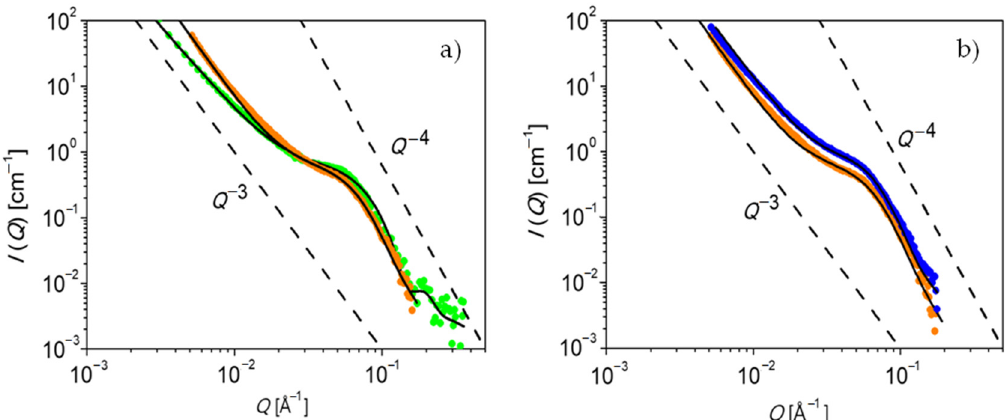
Figure 6. ( a ) Small angle scattering data of PEG-upy at T = 333 K, green circles: SANS; orange circles: SAXS; ( b ) SAXS data of PEG-upy at T = 333 K: orange circle and T = 348 K: blue circles. The black lines correspond to the fit to the data with the Percus–Yevick model. The dashed black lines demonstrate the distinct Q dependence if the data would follow different power law, I ( Q ) ∝ Q − P , with P = 3 or P = 4.